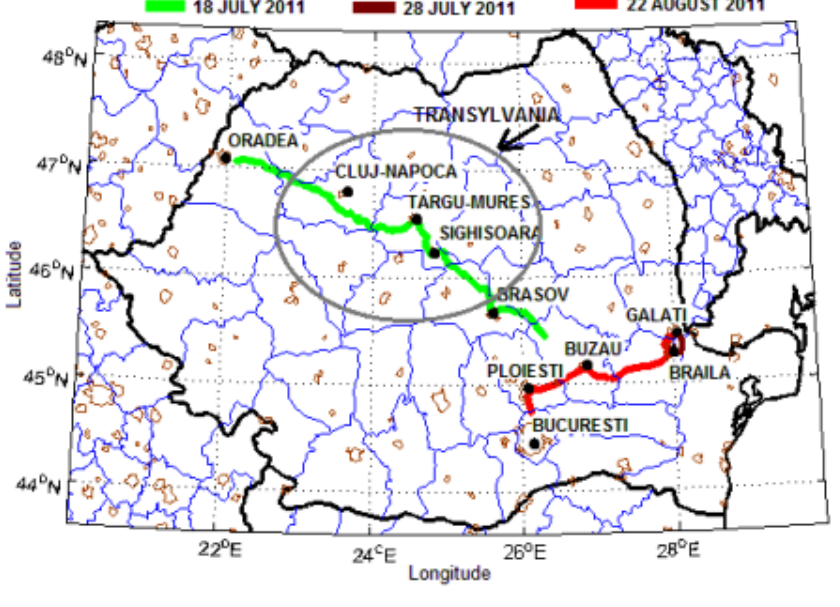
Figure 1. The tracks of mobile DOAS measurements performed in Romania.